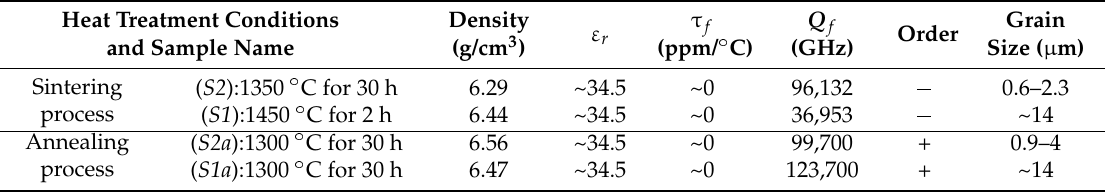
Table 2. Characteristics and dielectric properties (measured at 6 GHz) of BCZN specimens S1 , S2 , S1a and S2a